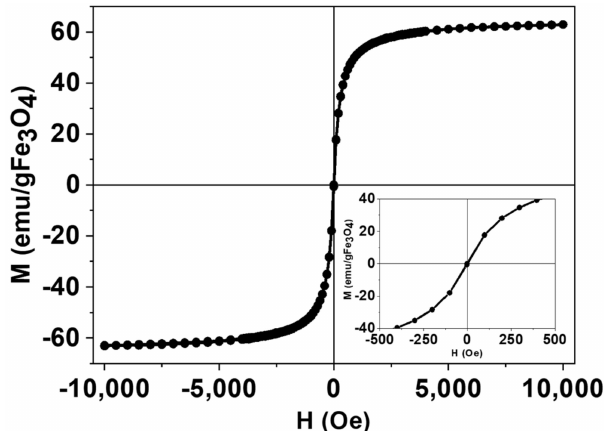
Figure 3. Magnetic hysteresis loop of a representative sample of Fe 3 O 4 @Al(OH) 3 NPs, normalized to the magnetite content and showing nearly superparamagnetic (SPM) behavior, with negligible values of coercivity and remanence.